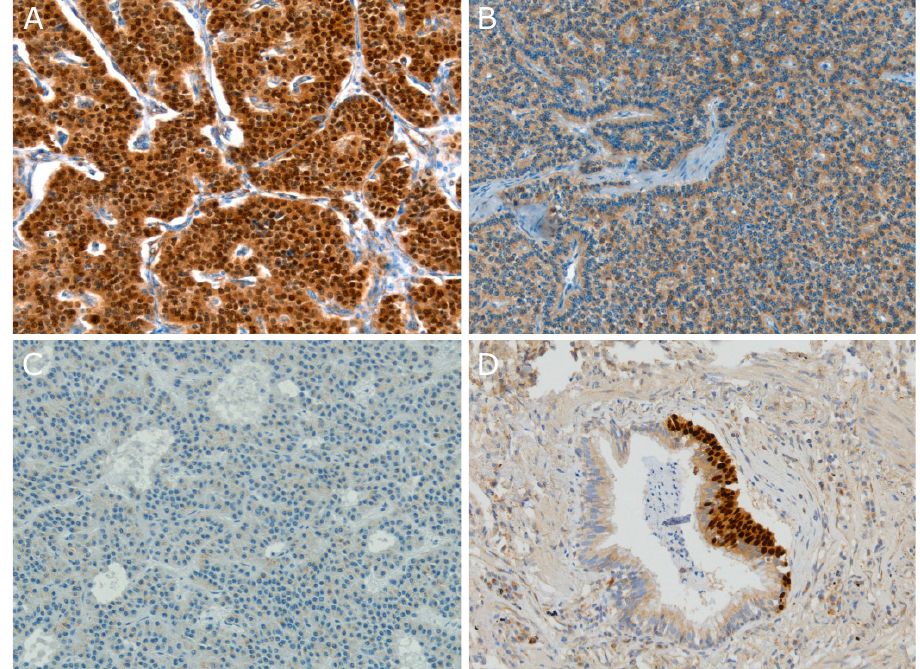
Figure 1. Orthopedia homeobox (OTP) immunohistochemistry of pulmonary carcinoids and neuroendocrine cell hyperplasia (NECH). ( A ) Representative image of nuclear OTP (nOTP) and cytoplasmic OTP (cOTP) staining in a typical carcinoid; ( B ) Representative image of a carcinoid tumor harbouring only cytoplasmic immunoreactivity for OTP; ( C ) Representative image of a carcinoid tumor with no OTP immunoreactivity; ( D ) Representative image of both nOTP and cOTP staining in NECH (magnification 200×) [14,16] .